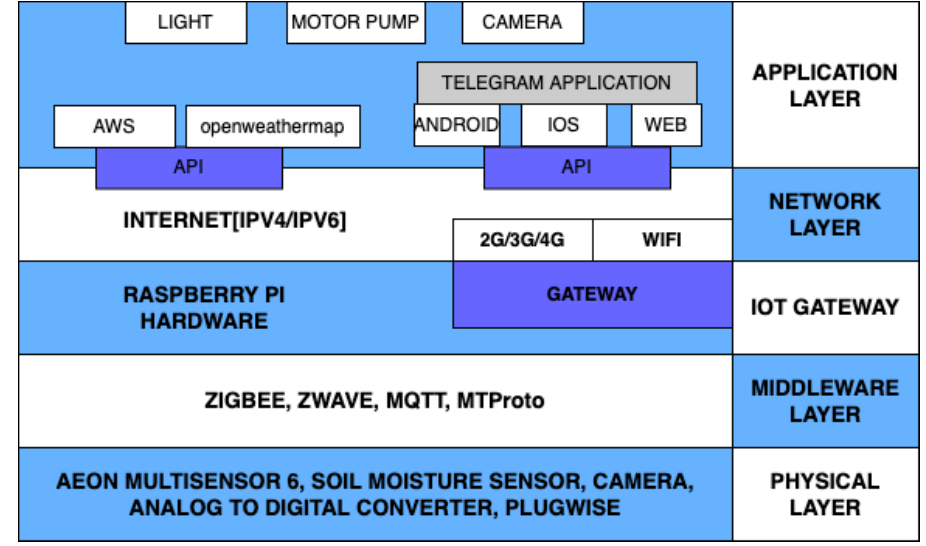
Figure 1. Smart Garden System Architecture